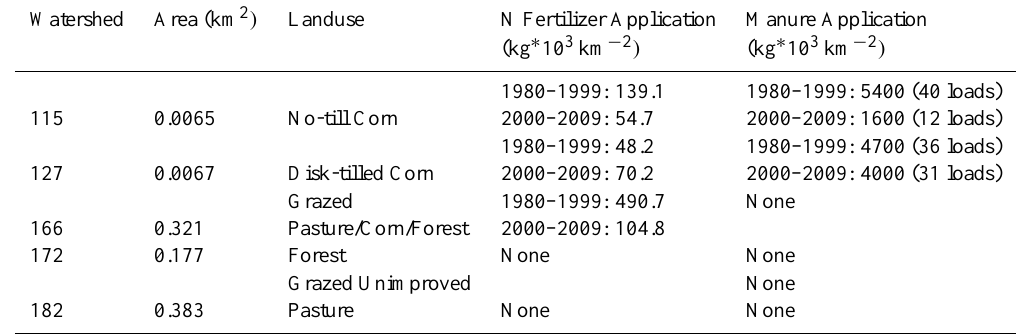
Table 1. Watershed area, landuse during study period, N-fertilizer and manure applications* during 1980–1999 and 2000–2009 for NAEW